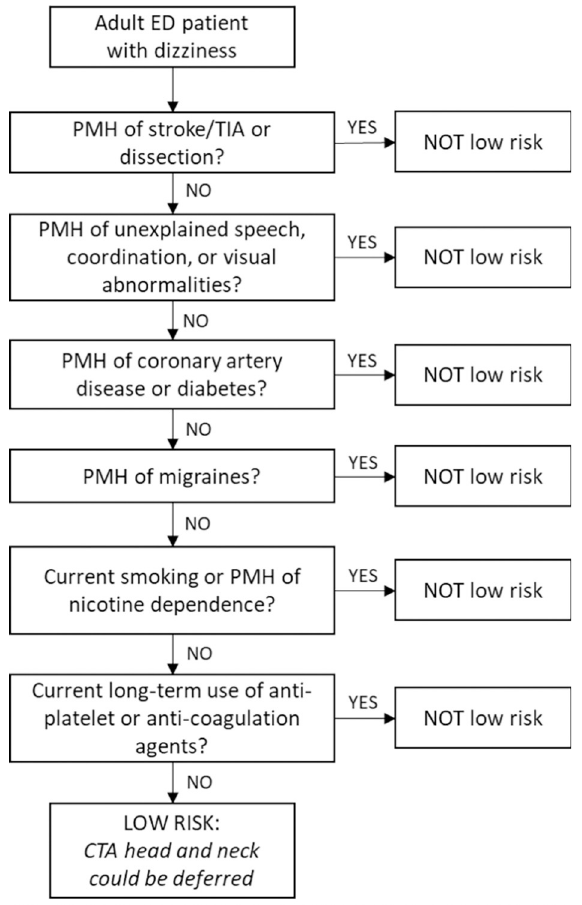
Fig 2. Visualization of a potential decision rule to exclude acute vascular pathology in adult ED patients with chief complaint of dizziness. Clinical criteria are grouped into closely related categories. Further development and validation are needed prior to application in clinical